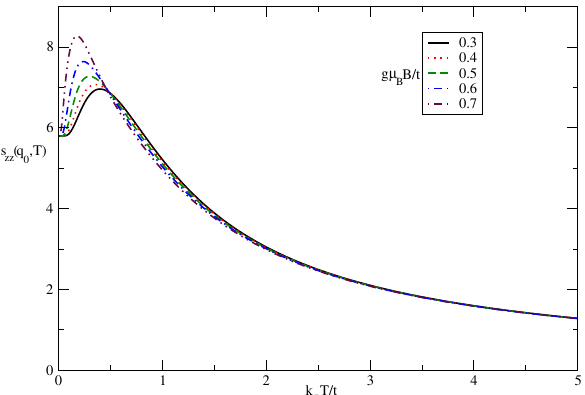
Figure 8. The longitudinal static spin structure factor s zz ( q 0 , T ) of undoped Germanene layer versus normalized temperature k B T / t for different values of magnetic field g µ B B / t at fixed spin-orbit coupling 0.4 . strength (cid:31) / t =